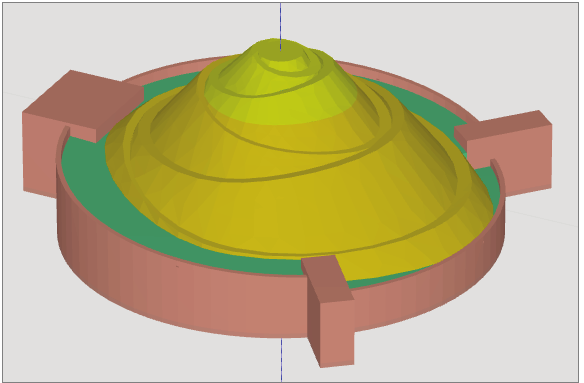
Fig. 6. Terramesh and Mac Mat geonet modelled in Plaxis application